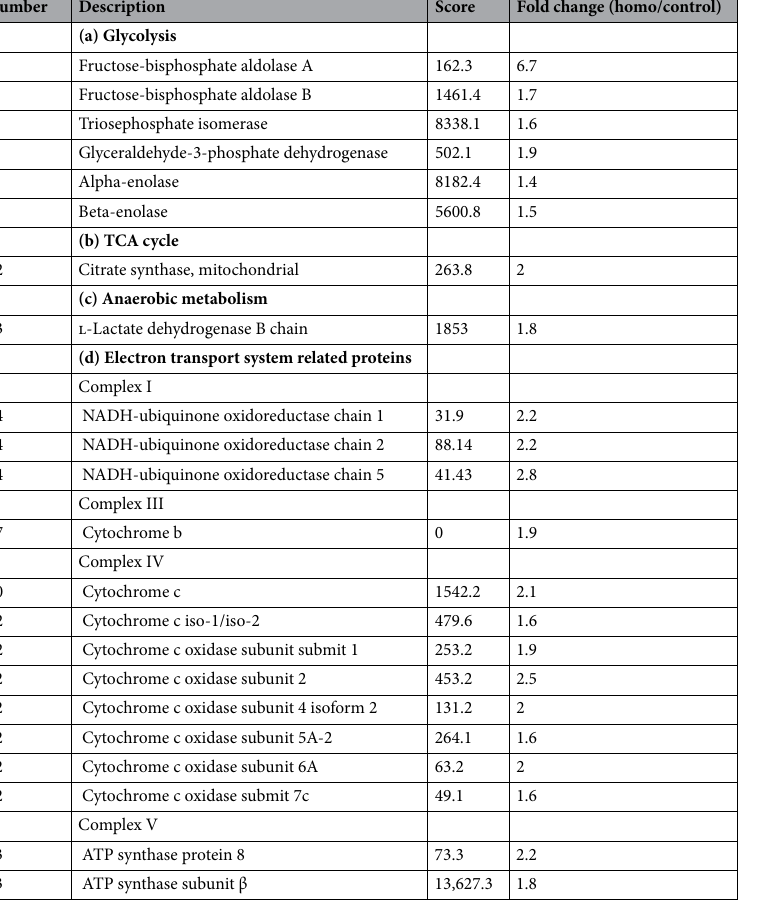
Table 1. Glycolysis-, aerobic-metabolism-, anaerobic-metabolism-, and electron-transport-chain-related